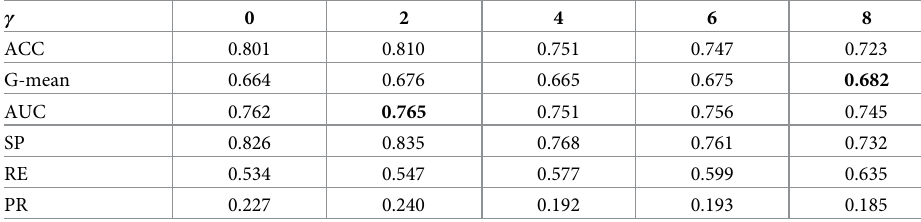
Table 13. Comparative analysis of CSDNN-FL versus γ using the MOMI Full dataset. ACC, SP, PR, and RE repre- sents accuracy, specificity, precision, and recall, respectively. The highest G-mean and AUC values are denoted in bold. The parameter α is set as 0.92.